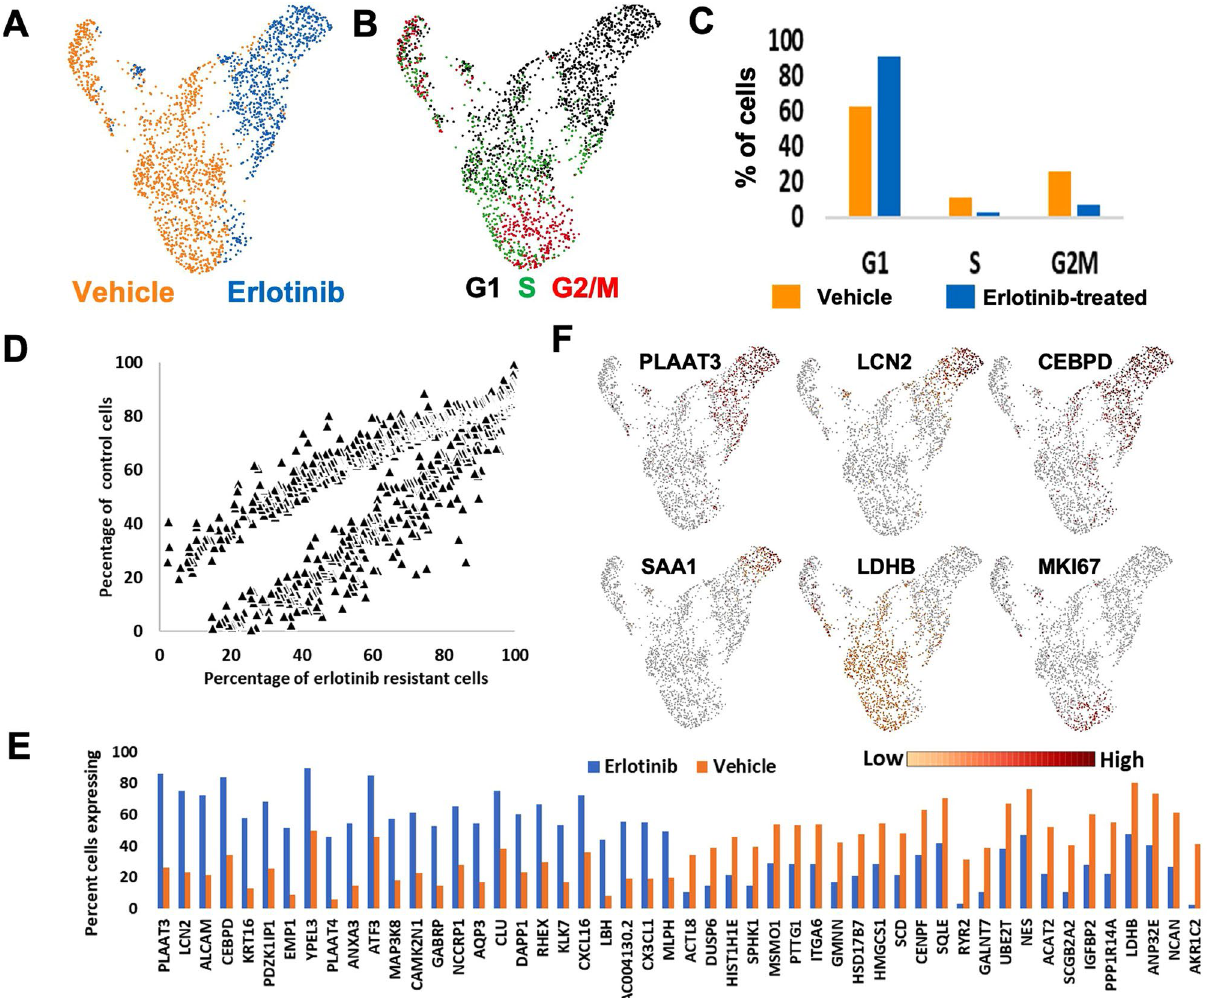
Figure 3. Single-Cell RNA sequencing identified subpopulations that mediate erlotinib resistance. Uniform Manifold Approximation and Projection (UMAP) plots of scRNA-seq data from vehicle or erlotinib-treated WHIM2 tumors. UMAP plots are two-dimensional plots depicting clusters of specific cell types (e.g. vehicle vs erlotinib-treated). UMAP plots are colored based on ( A ) treatment status or; ( B ) cell cycle status as assessed through cell cycle phase-specific gene signatures; ( C ) The proportion of cells from the vehicle tumor and erlotinib-treated tumor in each phase of the cell cycle, as shown in plot B; ( D ) Plotted are 1,103 transcripts identified as significantly differentially expressed between treatment conditions. Each axis shows the percentage of cells in each treatment condition that expressed the RNA transcript; ( E ) Plot depicting the 25 most differentially upregulated genes each treatment condition, as determined by the percentage of cells in the sample expressing each transcript; ( F ) UMAP plots depicting examples of genes that were differentially expressed following erlotinib treatment; MKI67 is shown to label G2/M